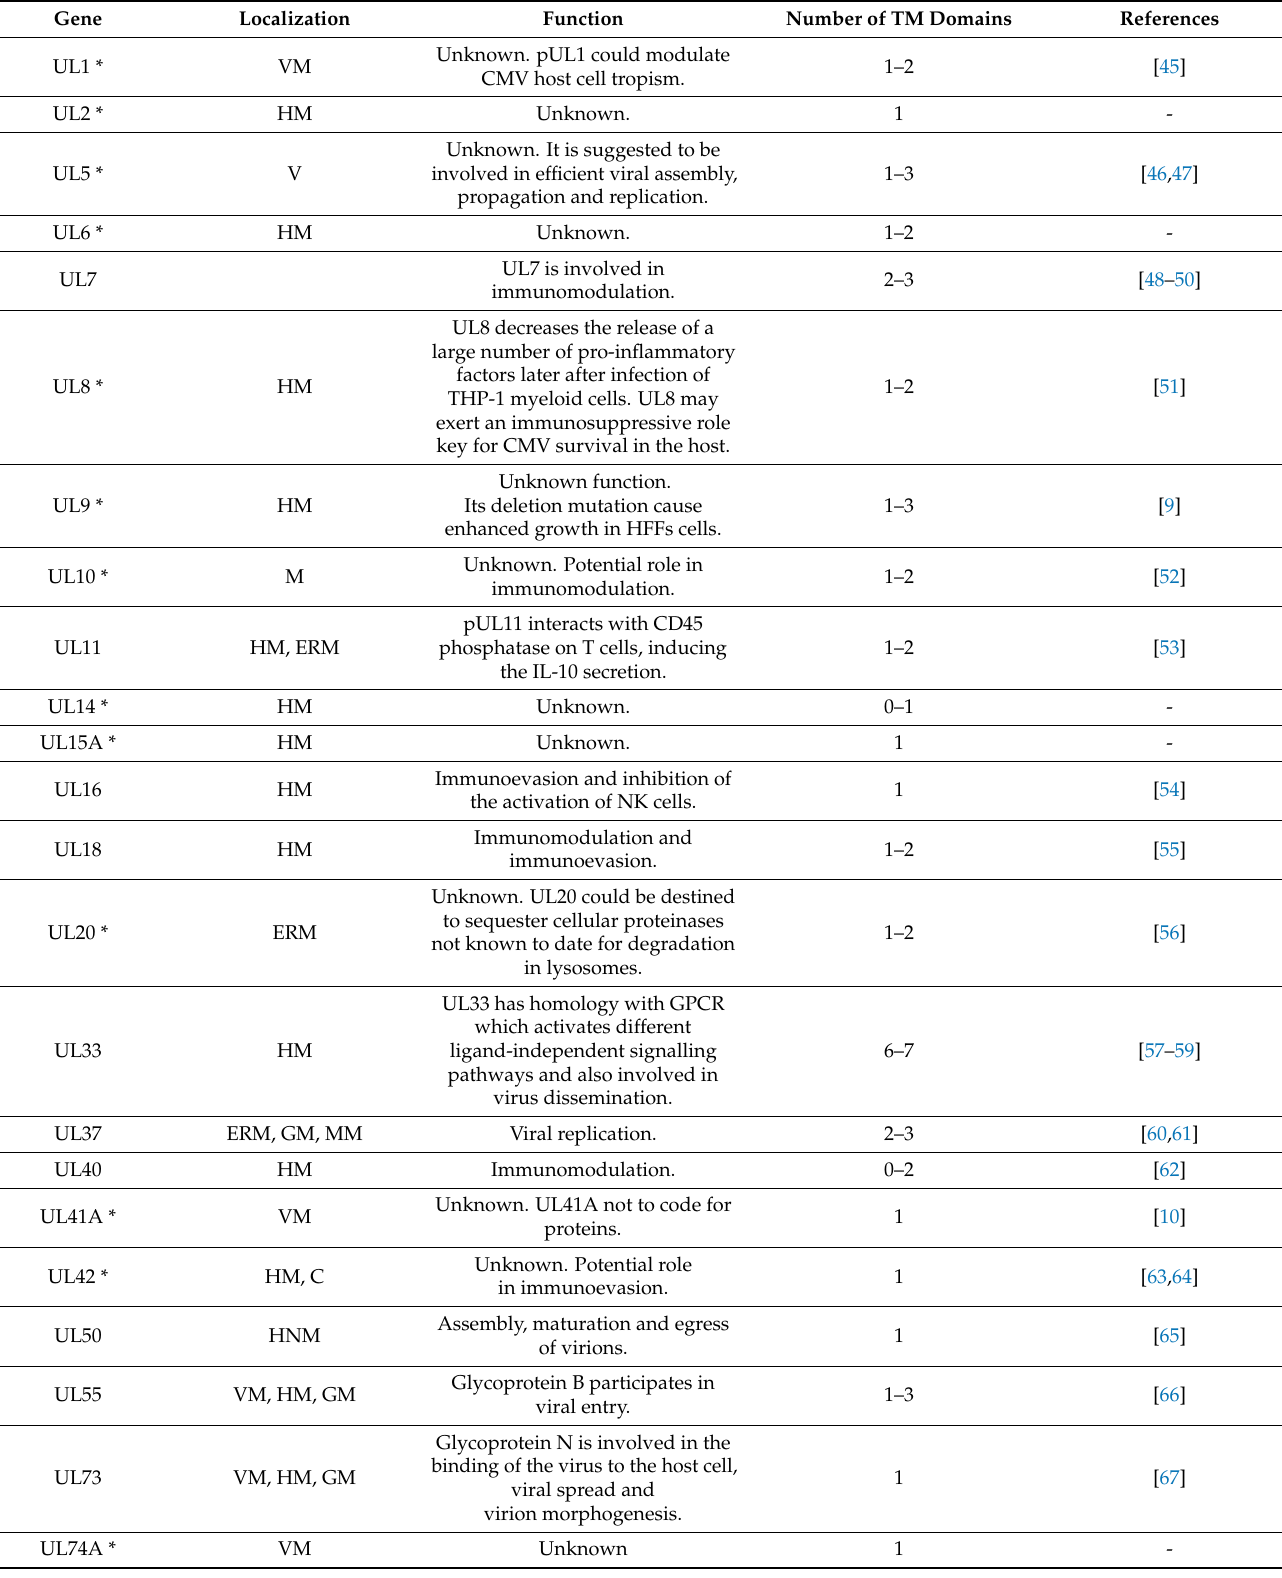
Table 2. CMV predicted transmembrane proteins indicating the cellular localization based on biotool Uniprop, the ascribed functions based on a bibliographic search and the number of predicted domains using the three different tools. (*) indicates unknown or non-verified